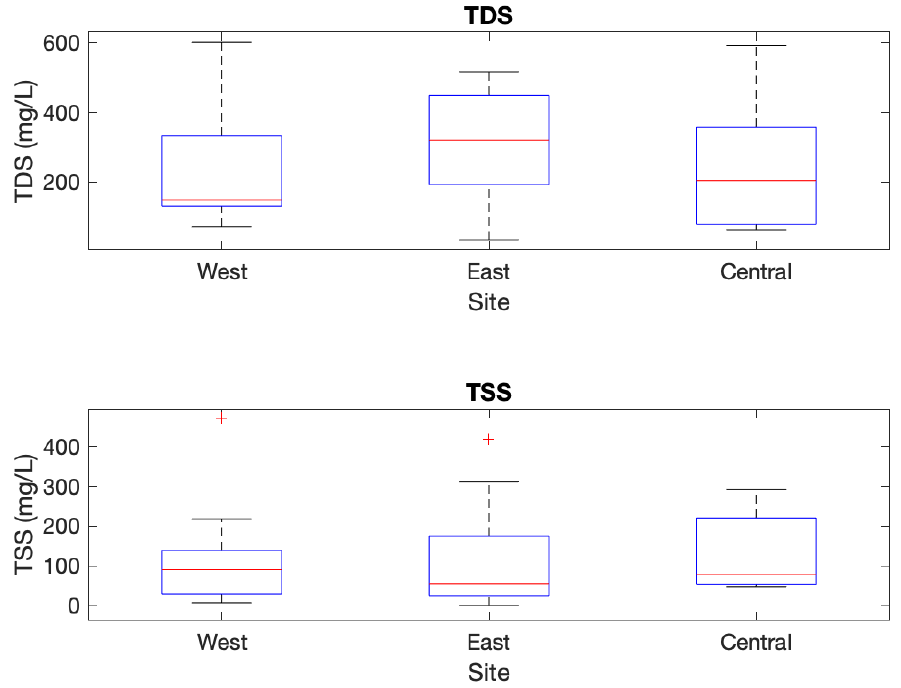
Figure A2. Wet weather water quality—TSS and TDS. Red plus signs indicate outliers.